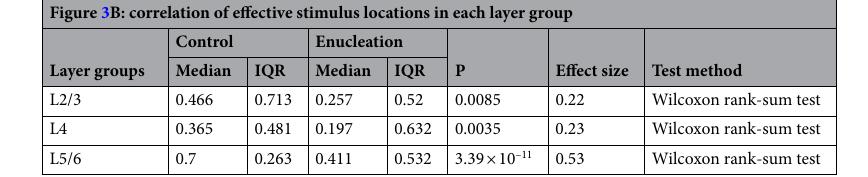
Table 3. Statistics in Fig. 3. IQR: interquartile range.